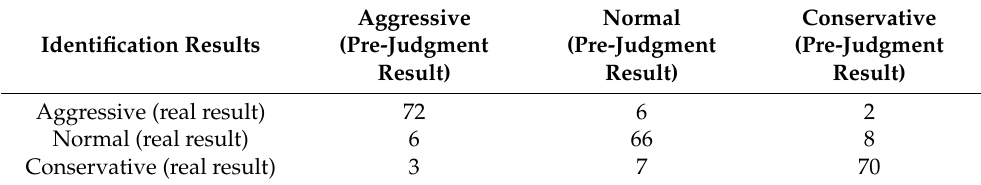
Table 16. GRNN driving propensity identification results.